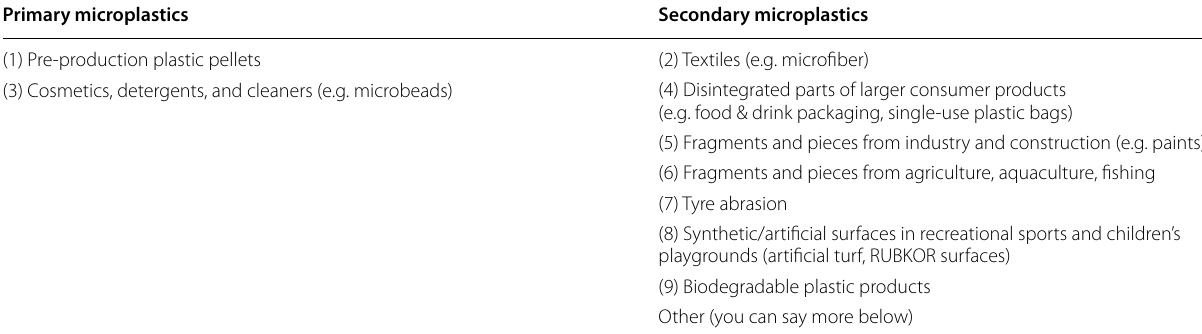
Note : The final selection of the presented microplastics sources were based on GESAMP ([29], Chapter 2 Sources of Microplastics). The ratings were done twice, once for the natural environment impacts and once for human health impacts